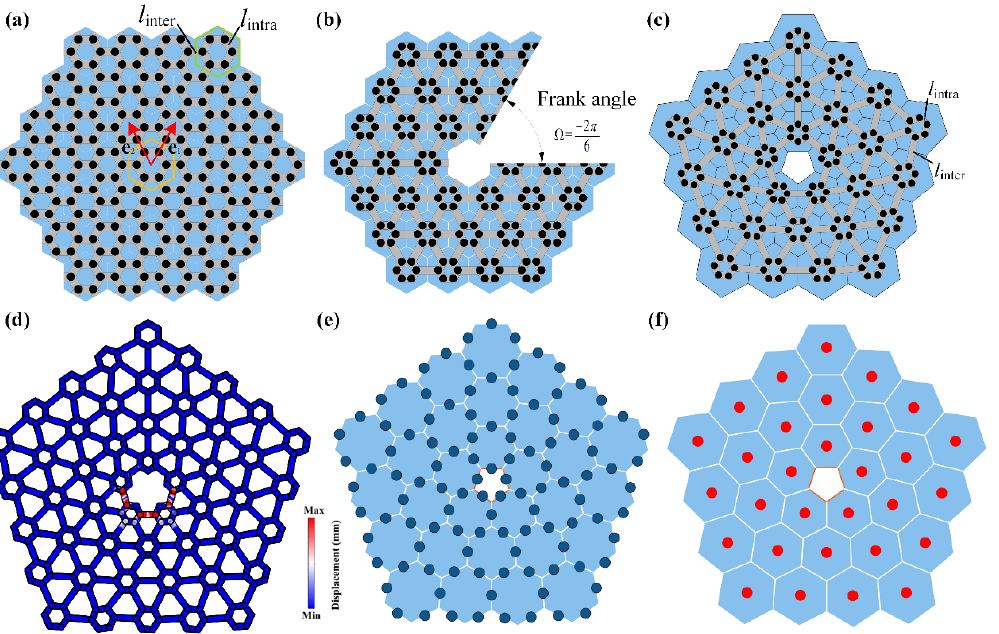
Figure 10. Bulk – disclination correspondence in elastic phononic plates. ( a ) The hexagonal lattices. The lengths of the intercell (intracell) beams are denoted by l inter and l intra . ( b ) The topological nontrivial structure with a missing π /3 crystalline wedge. ( c ) The topological nontrivial structure with a pentagonal core. ( d ) One of the eigenmodes of the elastic system with 30 unit cells. ( e ) The distributions of Wannier centers (blue solid circles) of the topological nontrivial structure. ( f ) The distributions of Wannier centers (red solid circles) of the topological trivial structure.